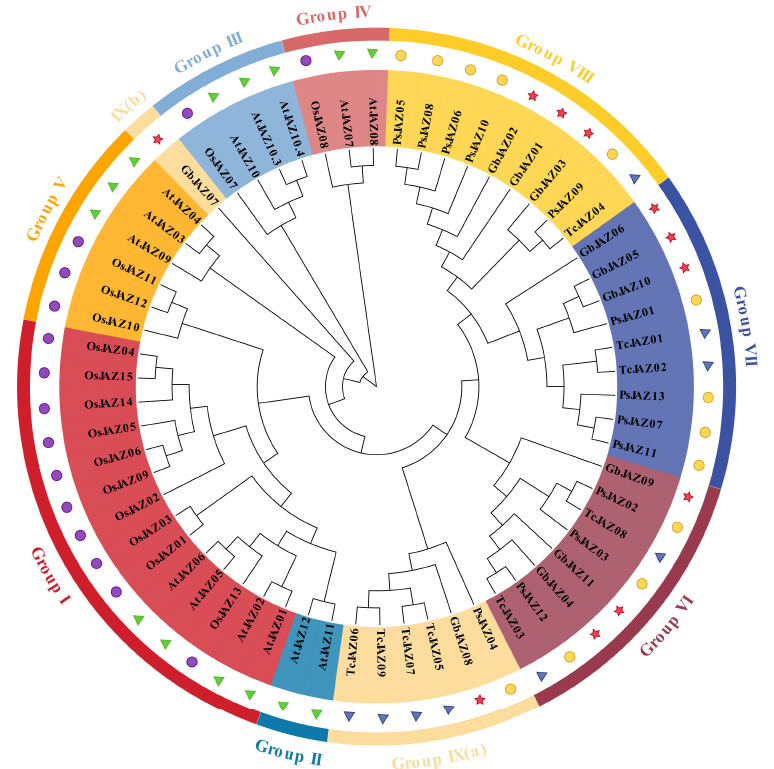
Figure 5. Phylogenetic tree of the JAZ family in Arabidopsis thaliana (At), Oryza sativa (Os), Picea sitchensis (Ps), Taxus chinensis (Tc) and Ginkgo biloba (Gb) JAZs. Different colored shapes represent different species, Arabidopsis thaliana (green triangle), Oryza sativa (purple circle), Picea sitchensis (yellow circle), Taxus chinensis (blue triangle), Ginkgo biloba (red star).